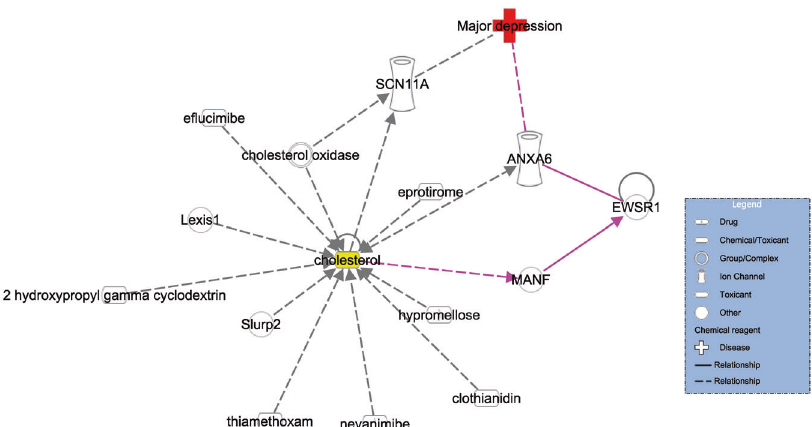
Fig. 2 Potential networks among cholesterol, MANF, and major depressive disorder. Ingenuity Pathway Analysis database indicates that the MANF/EWSR1/ANXA6 pathway might act as the connecting bridge between cholesterol and major depressive